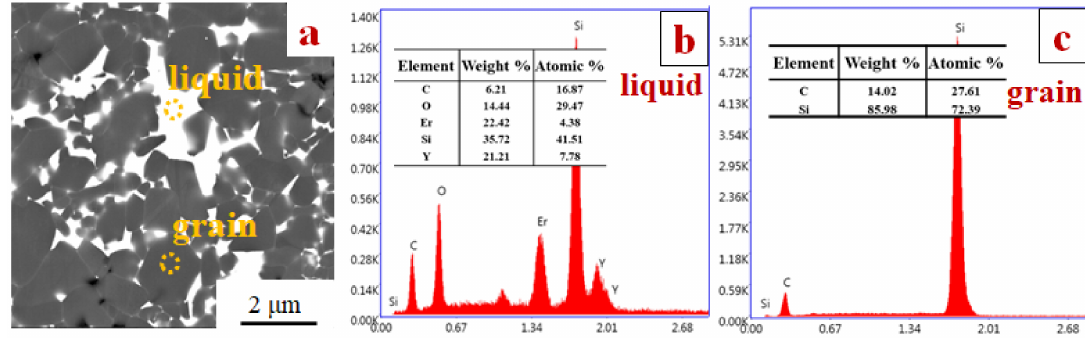
Figure 2. The microstructure and EDS results of SiC ceramics: ( a ) SEM, ( b ) EDS result for the secondary phase, and ( c ) EDS result for the grain.